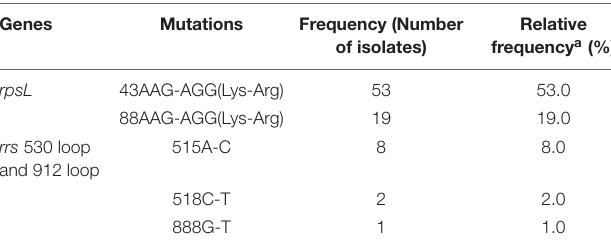
TABLE 6 | Mutation characterizations of rpsL and rrs 530 loop and 912 loop among 100 streptomycin resistant M. tuberculosis from China. Genes